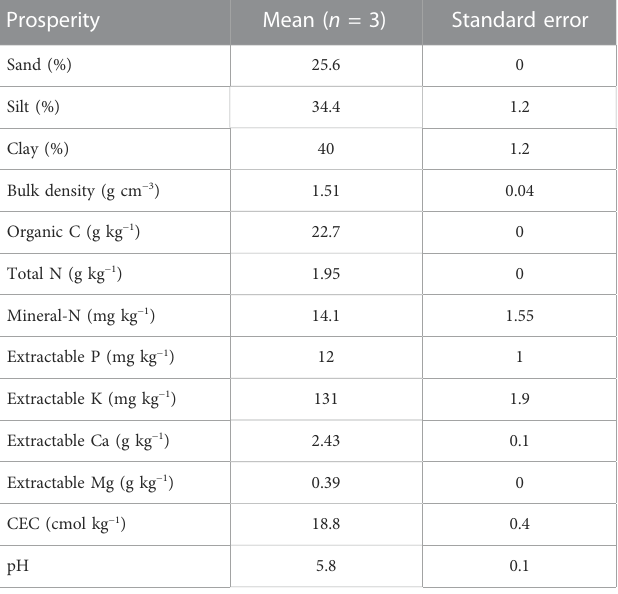
TABLE 2 Selected chemical and physical properties of a Brookston clay loam soil (0 – 15 cm) in this study.